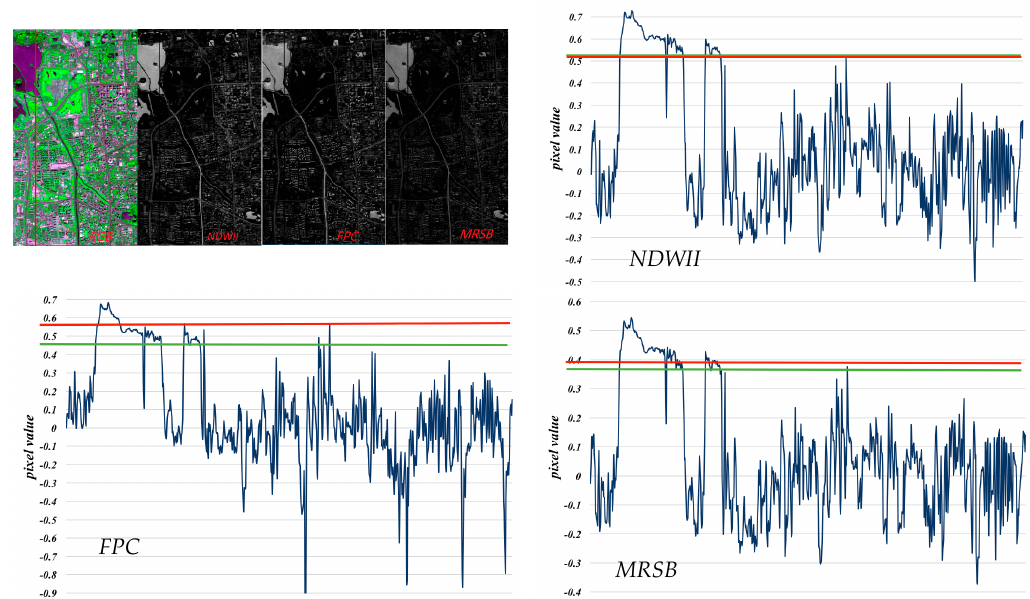
Figure 8. Local pixel value changes in different images of the water indices. For the three different approaches, the obtained MNDWI image can return two thresholds, shown as the red line and green line in the pixel value change curve. The red line means to obtain accurate water pixels without noise, while the green lines corresponds to extraction of the whole water pixels in spite of some error pixels. For the proposed NDWII approach, the red line and green line tend to be coincide, which means it can nearly extract all the water pixels with little noise.